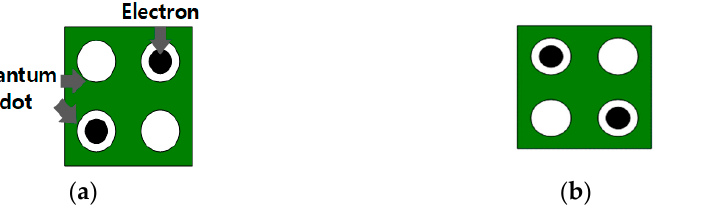
Figure 1. Two polarization states of QCA basic cell: ( a ) P = +1 (binary 1); ( b ) P = − 1 (binary 0).